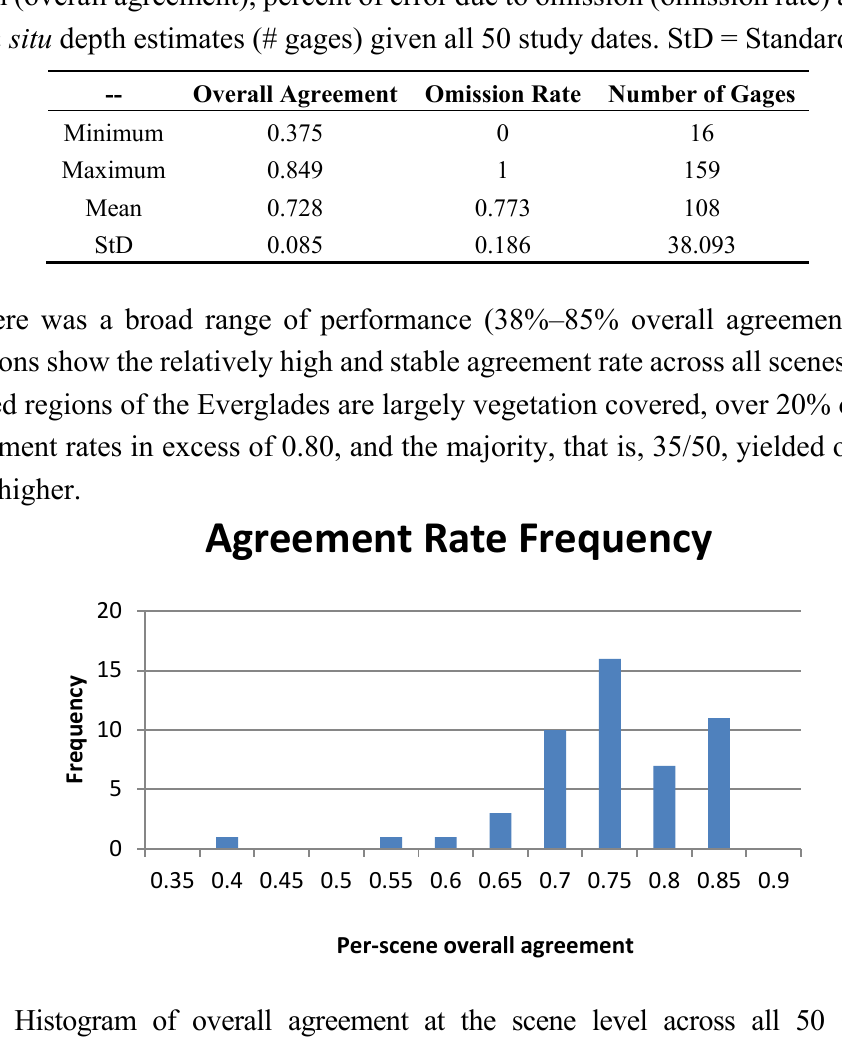
Figure 6. Histogram of overall agreement at the scene level across all 50 study